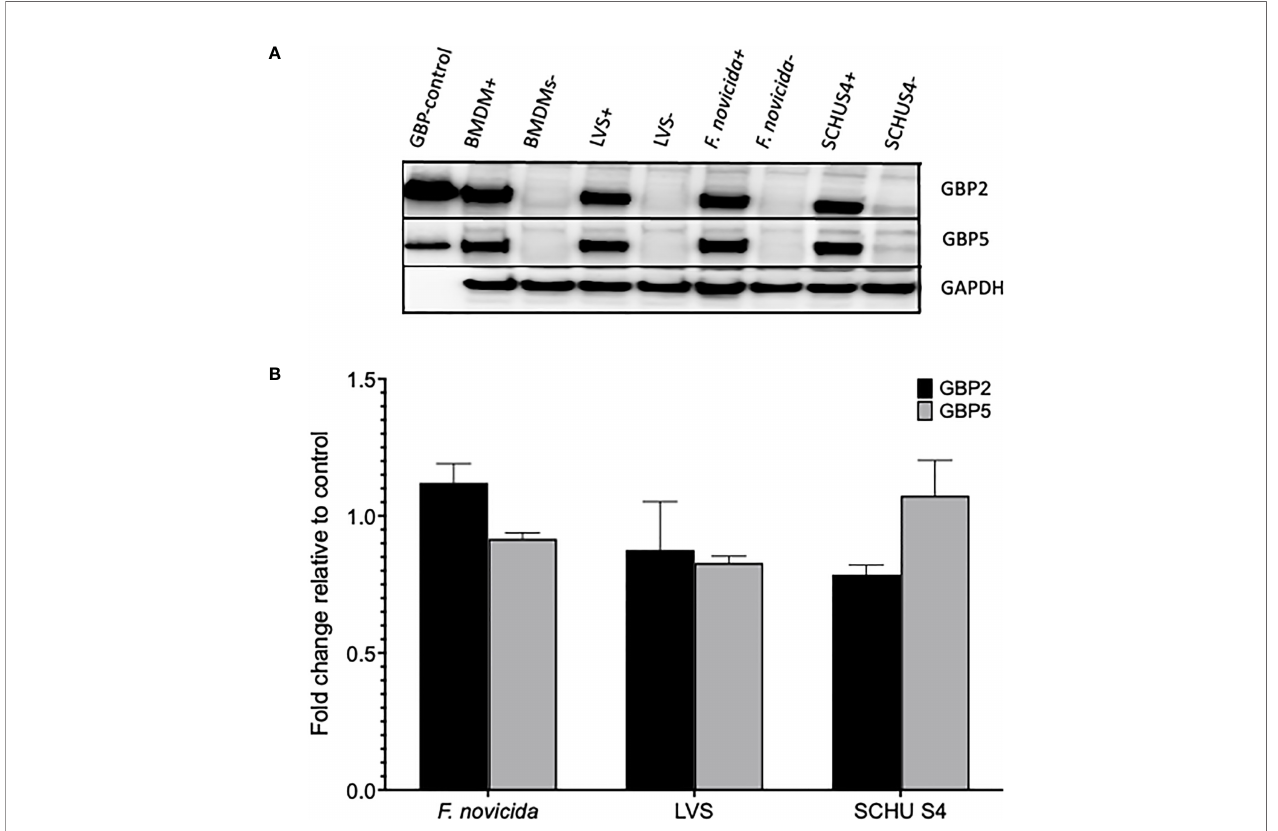
FIGURE 3 | (A) Western blot analysis of GBP2, GBP5, and GAPDH expression in cultures with wild-type BMDMs in the presence of (indicated with +), or absence of IFN- g (indicated with -) were infected with indicated F tularensis strains using an MOI of 100. (B) Quanti fi cation by densitometry of (A) . Mean values and SEM are